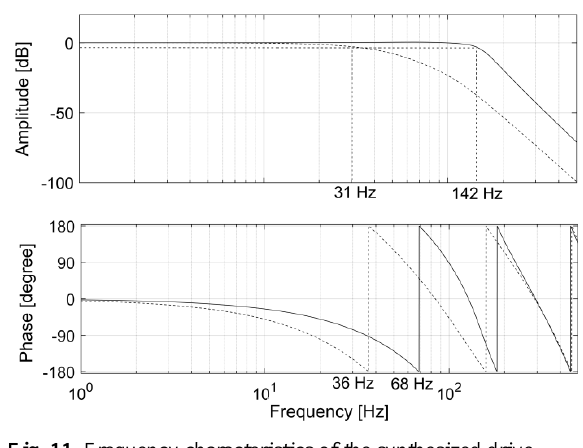
Fig. 11. Frequency characteristics of the synthesized drive ( Butterworth filter, binomial decomposition).